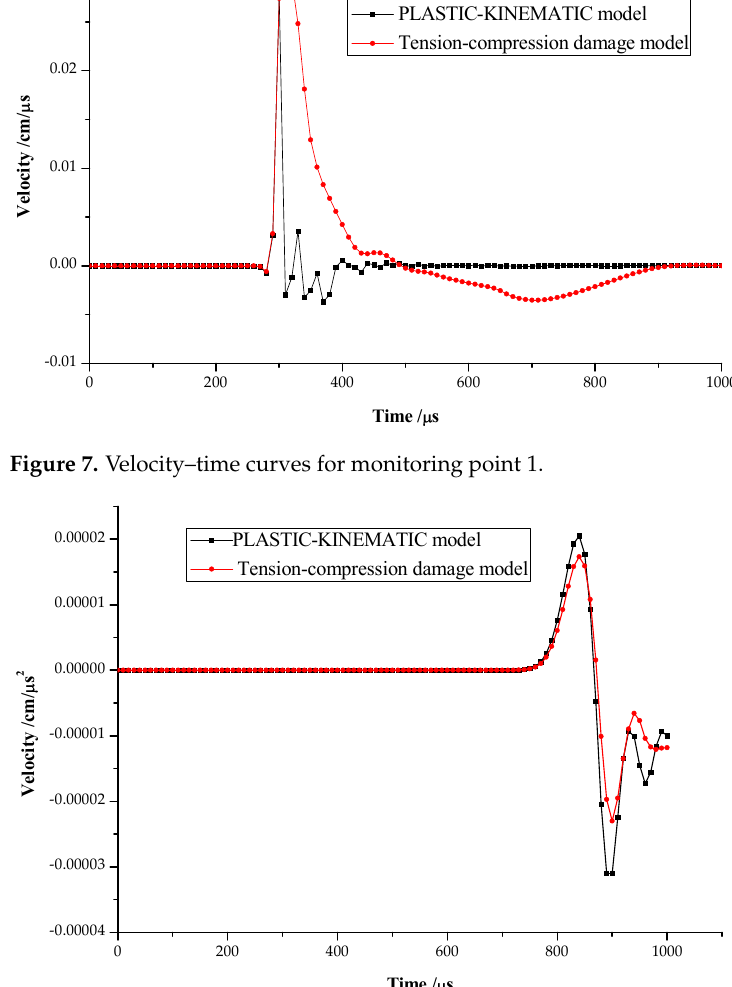
Figure 8. Velocity–time curves for monitoring point 2.